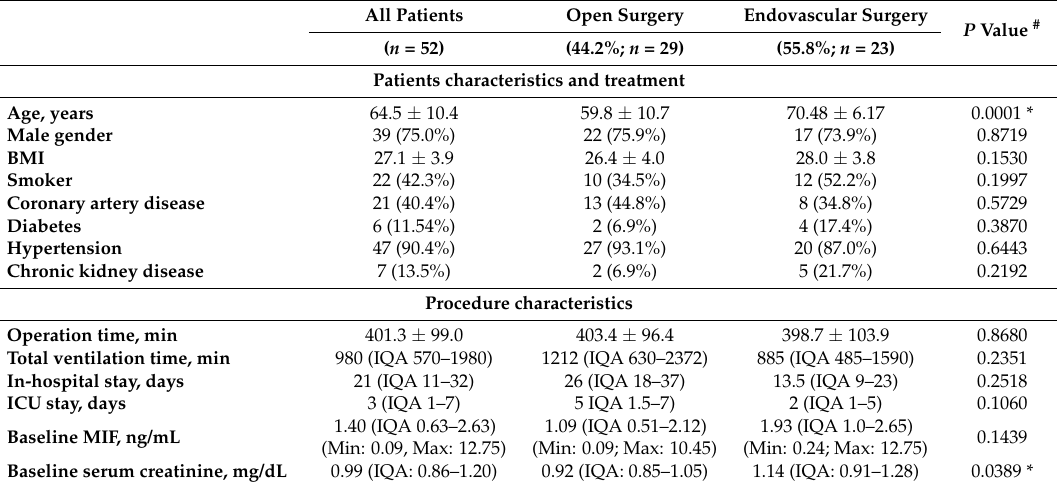
Table 1. Patient Characteristics According to Surgery